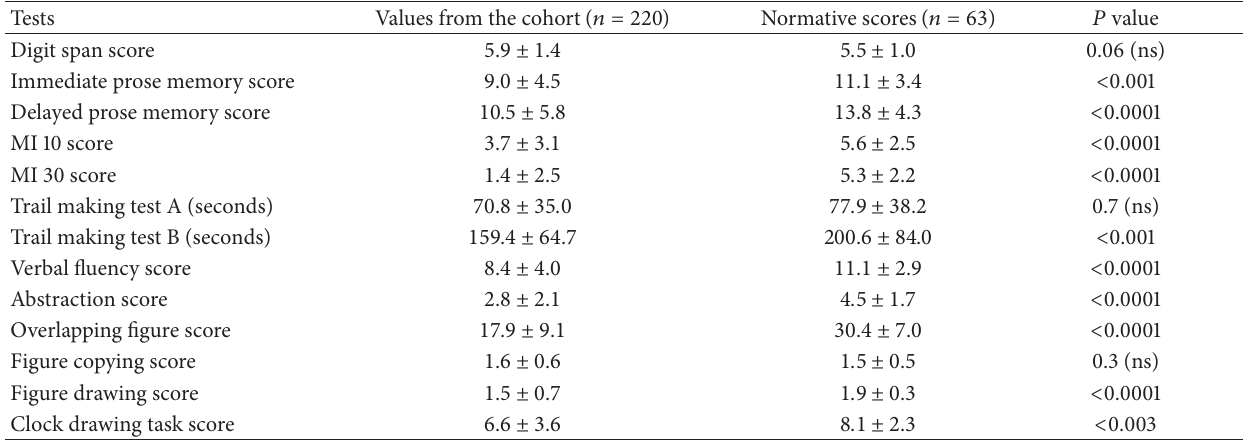
Table 2: Mean scores of the neuropsychological tests recorded in the study cohort. Italian normative scores for the same age and education are also shown